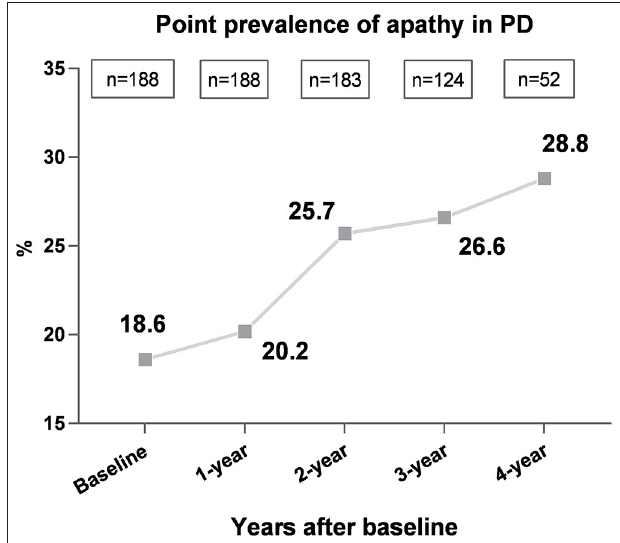
FIGURE 1 | Frequency of apathy over time in patients with PD. The prevalence of apathy in patients with PD increased with disease duration over time, which increased from 18.6% at baseline to 28.8% after 4